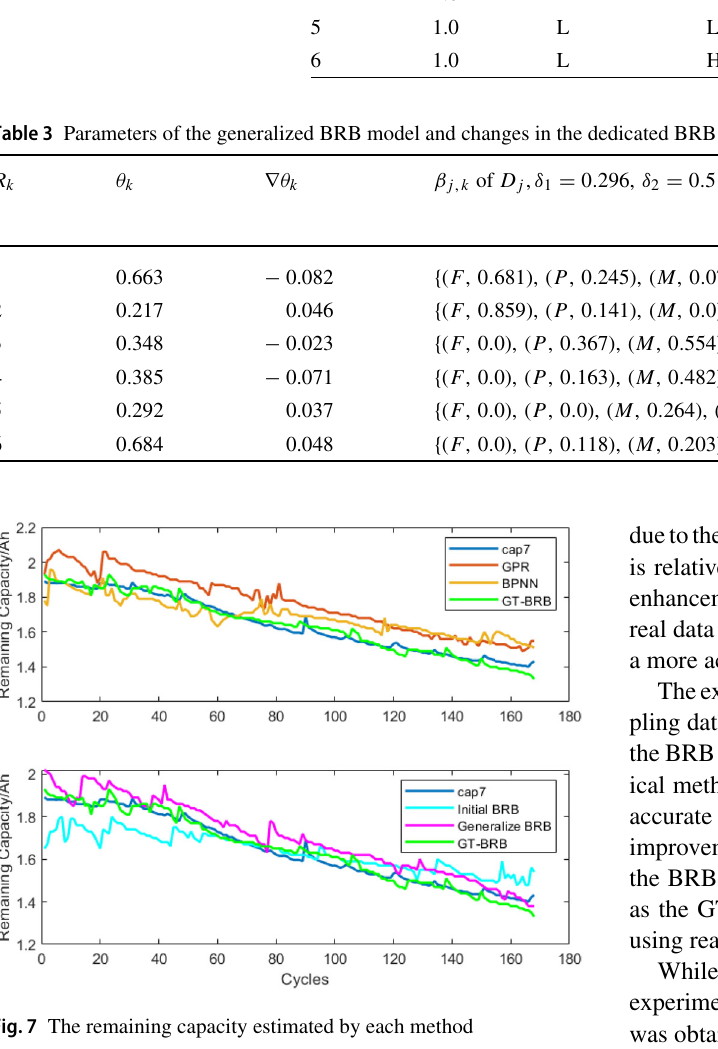
are used to fine-tune the generalized BRB model to obtain a dedicated BRB